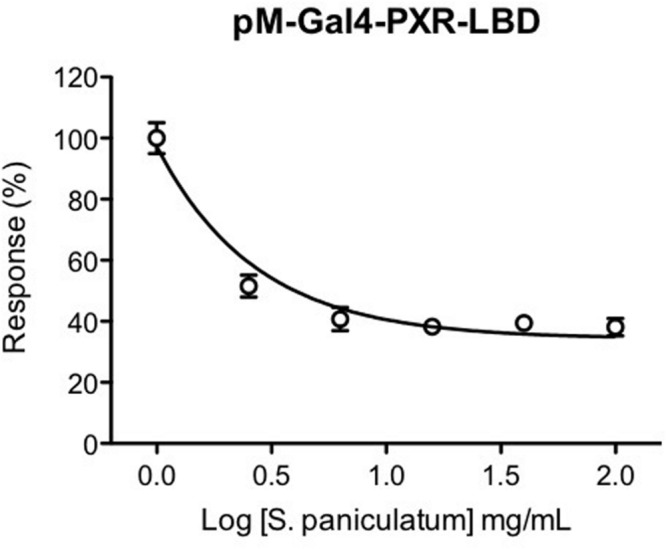
Antagonistic effect of Solanum paniculatum extract on rifampicin-induced hPXR activation. HeLa cells were co-transfected with expression vector pM-Gal4-PXR-LBD and Gal4 luciferase reporter and treated with increasing concentrations of Solanum paniculatum in the presence of rifampicin 1 μM (EC50). Luciferase activity was measured after 24 h and normalized as a percentage of rifampicin treated cells.